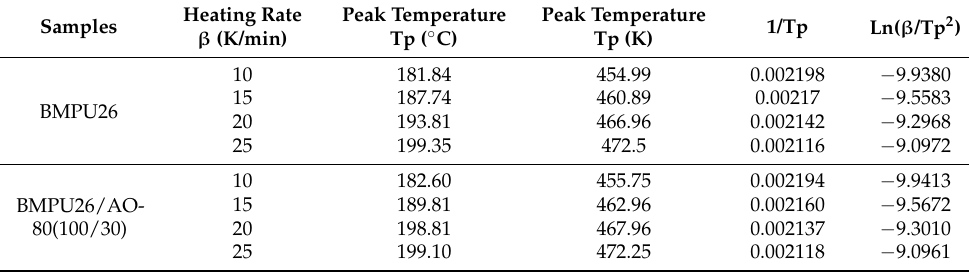
Figure 3. ( A ) DSC curves of BMPU26 at different heating rates. ( B ) DSC curves of BMPU26/AO-80(100/30) at different heating rates. ( C ) Dependence of ln( β Tp –2 ) on Tp –1 for BMPU26. ( D ) Dependence of ln( β Tp –2 ) on Tp –1 for BMPU26/AO-80(100/30). Table 1. Temperatures of the main thermal events of the samples.